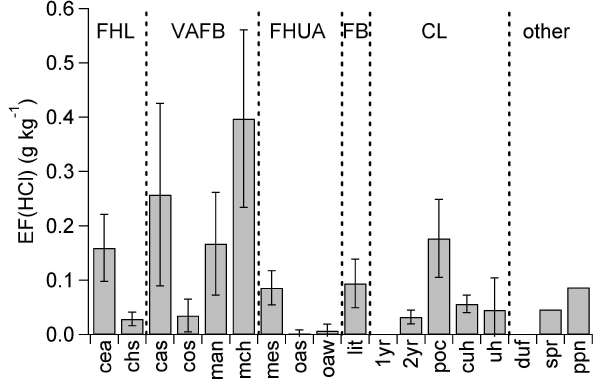
Fig. 9. HCl emission factors by fuel type. See Table 1 for fuel